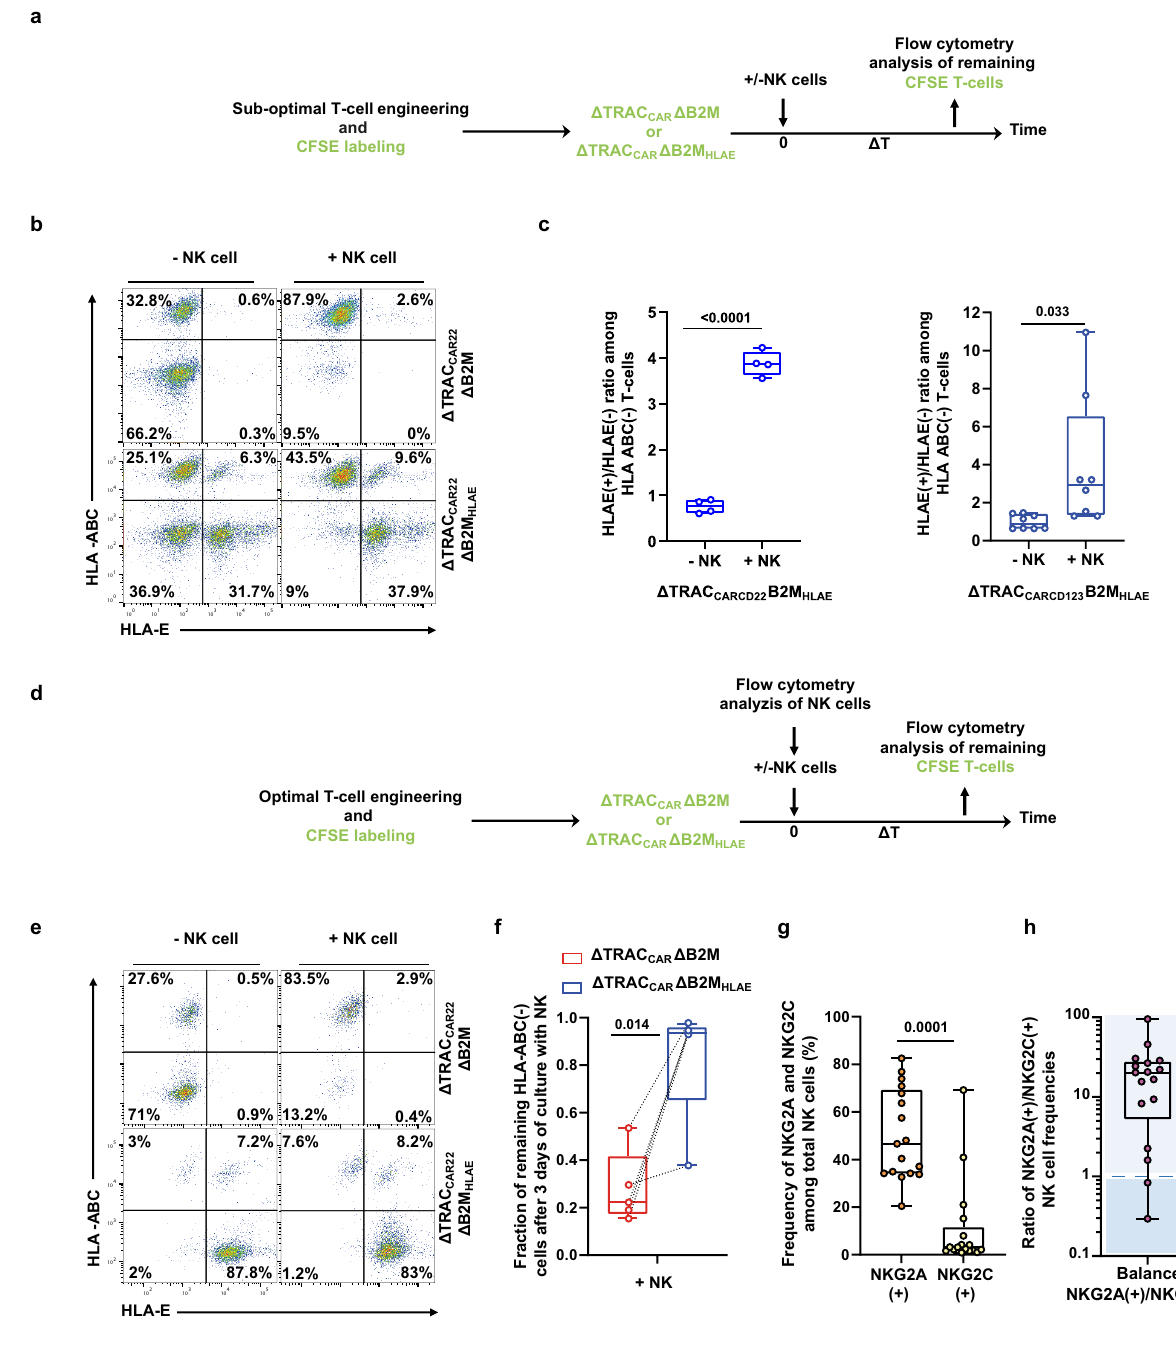
fi tness, and cytotoxicity of clinically relevant primary NK cells obtained from several ALL and AML patients. Because NK-cell numbers and fi tness can be affected by previous treatment and by the nature and stage of each disease, we selected patient samples obtained before and after conventional frontline therapy. We fi rst selected a cohort 23 ALL patients and 27 AML patients treated with induction therapy (7 + 3 anthracycline, cytarabine), and thoroughly investigated the phenotype of their NK-cell sub- populations using mass cytometry (Fig. 5a). The frequencies (Fig. 5b, left panel) and absolute counts (Supplementary Fig. 6) of NK cells were comparable between the different cohorts. One exception could be however noticed